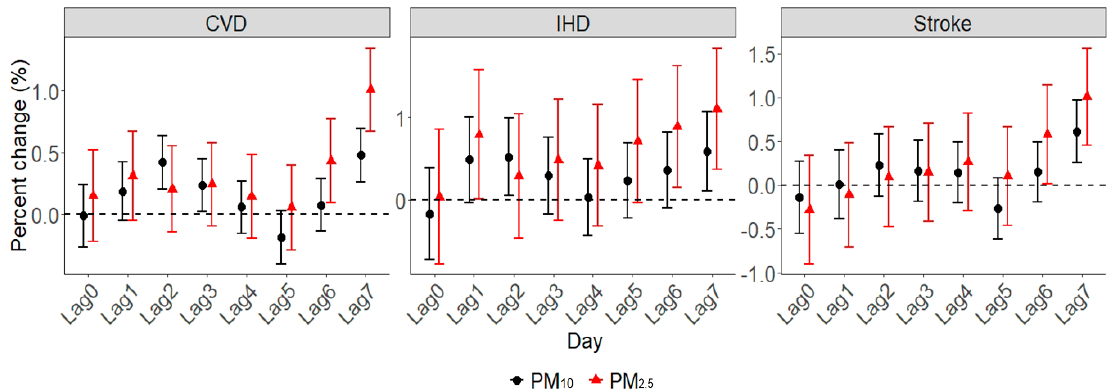
Figure 2. The estimated percent change of cardiovascular disease (CVD) hospitalizations due to a 10 µg/m 3 increase in PM 2.5 and PM 10 concentrations.